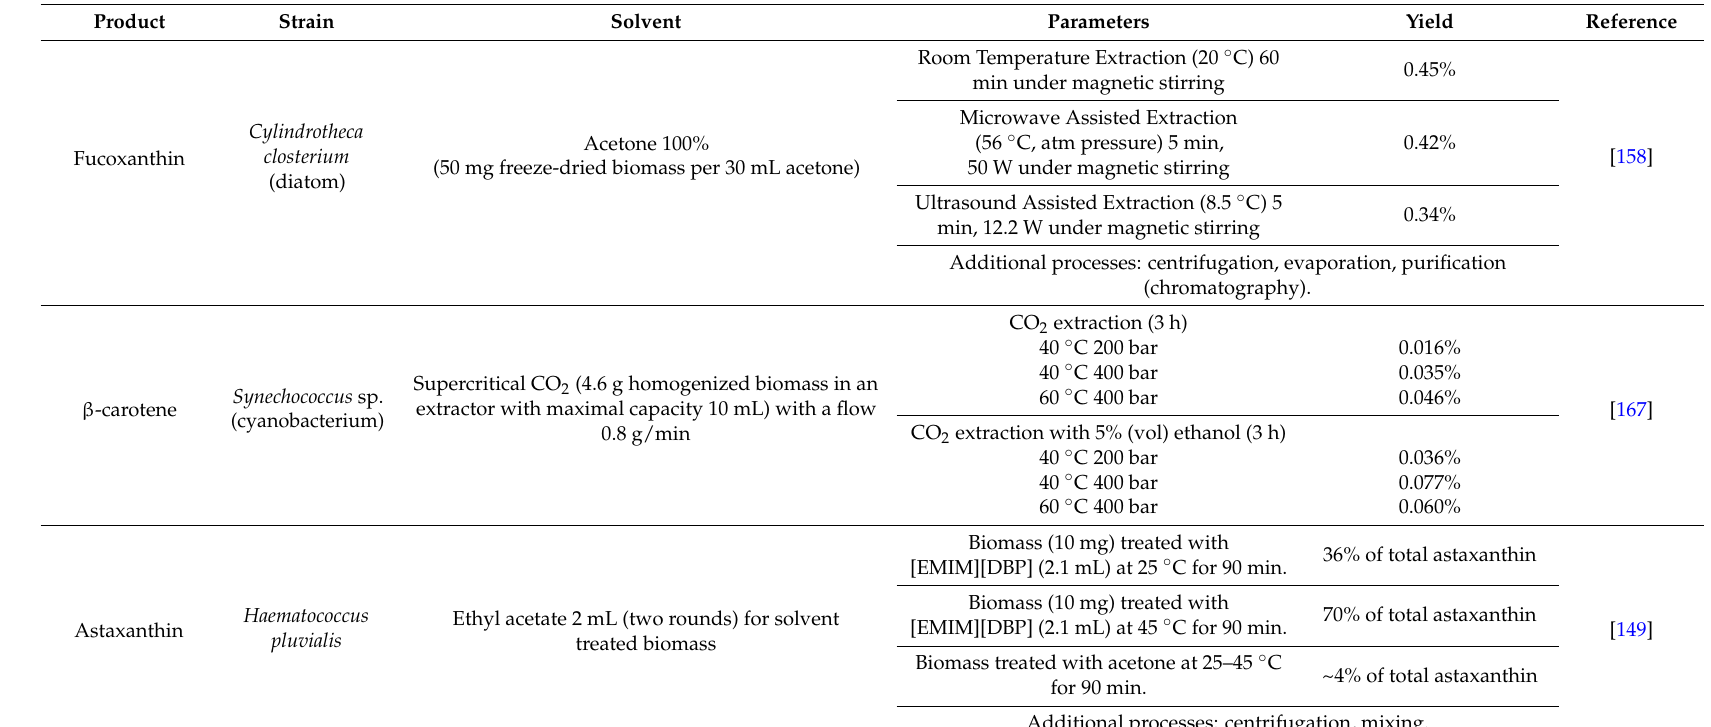
Table 2. Effect of different techniques, process parameters and solvents on carotenoid extraction yields from microalgal